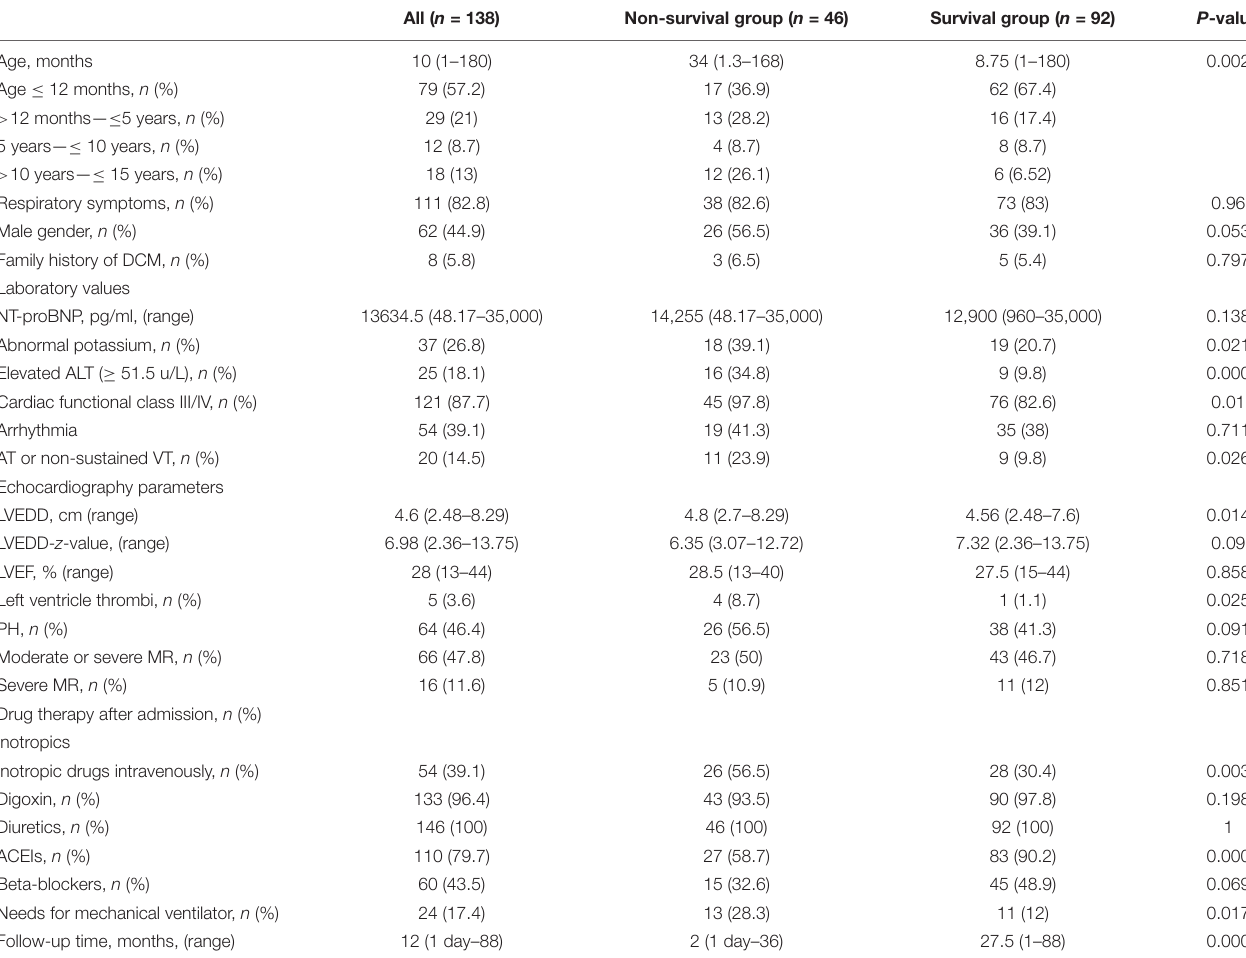
TABLE 1 | Clinical characteristics of pediatric patients with primary DCM in the non-survival and survival